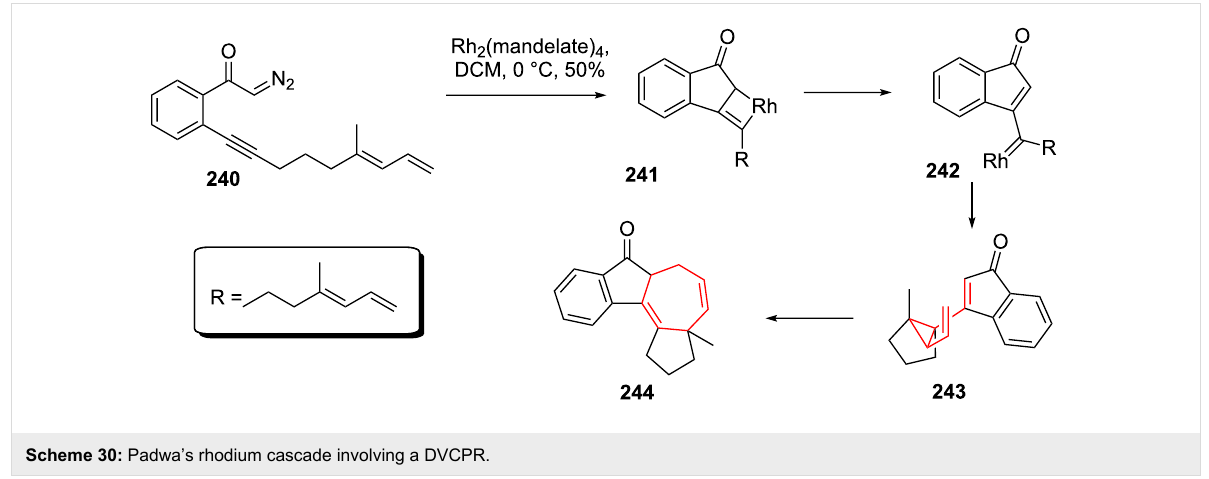
Scheme 30: Padwa’s rhodium cascade involving a DVCPR.